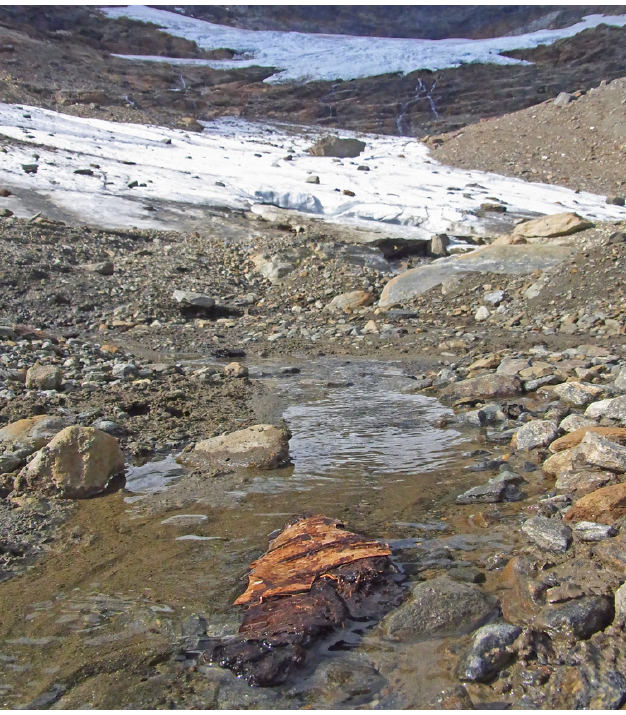
Figure 17: Kåppasglaciären (11). Recently outwashed birch log. 6980 cal. yr BP (Beta-284462).